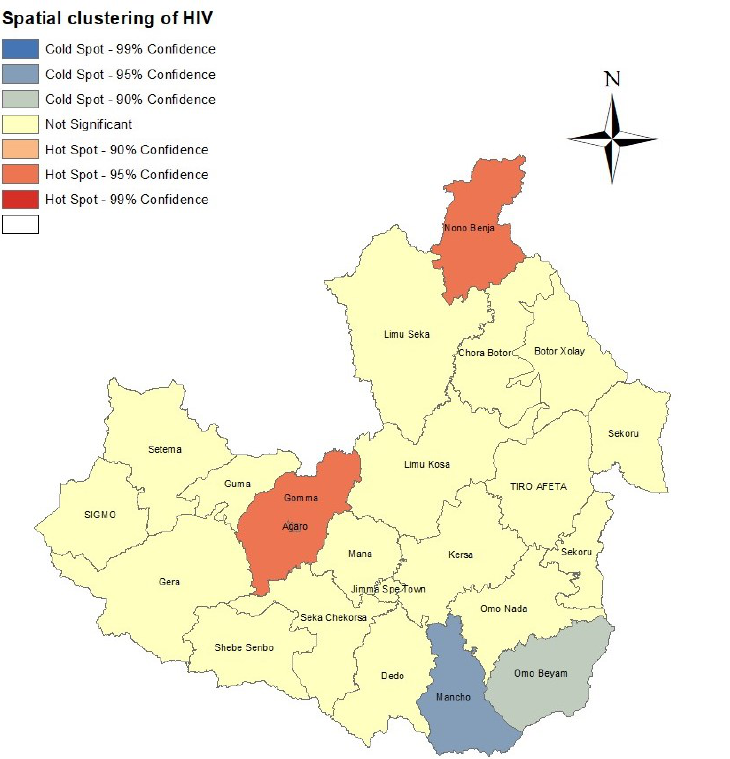
Figure 2. Spatial clustering of HIV prevalence in Jimma Zone at district level based on the Getis–Ord G ∗ i